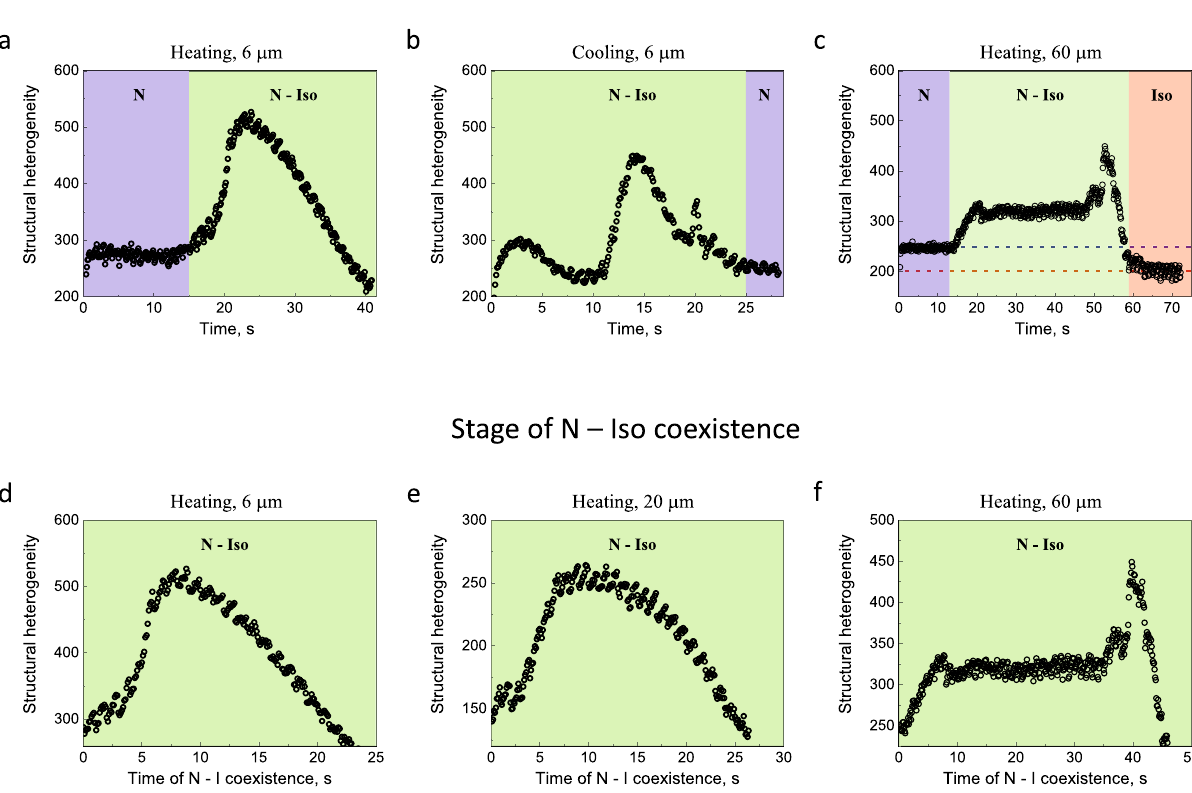
Fig. 2 Time dynamics of the structural heterogeneity. In all plots the horizontal axis is the time of the video frames of the capillary and the vertical axis is the corresponding structural heterogeneity. a, b The structural heterogeneity of the heating and cooling process respectively in a 6 μ m capillary. c The entire nematic-isotropic transition in a 60 μ m capillary that shows the difference of the structural heterogeneity in the nematic (left) and isotropic (right) state; the nematic, nematic-isotropic and isotropic states of the liquid crystal are highlighted in blue, green and red, respectively. d – f Increase of the time range of coexistence of nematic and isotropic domains in capillary of 6 μ m, 20 μ m and 60 μ m,